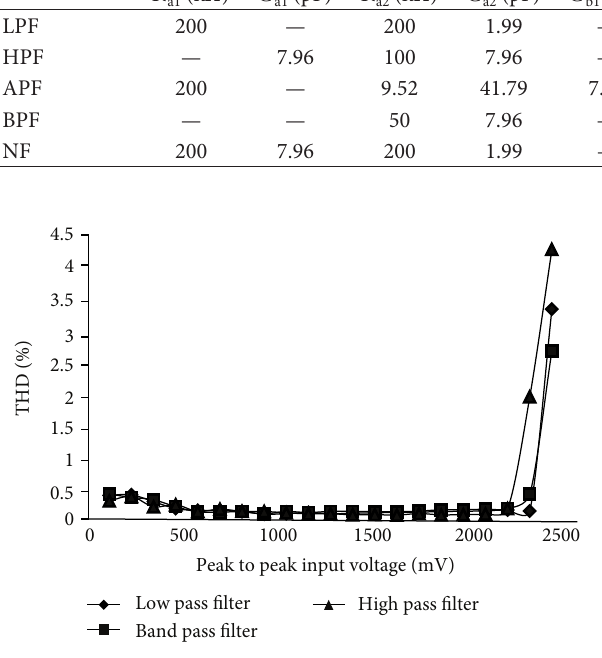
T 3: Designed values of passive components used for VM third order �lters. Filter